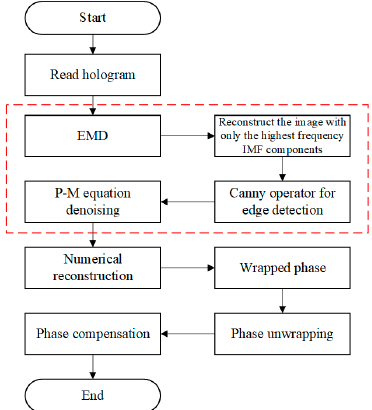
Figure 2. The flowchart of the method proposed in this